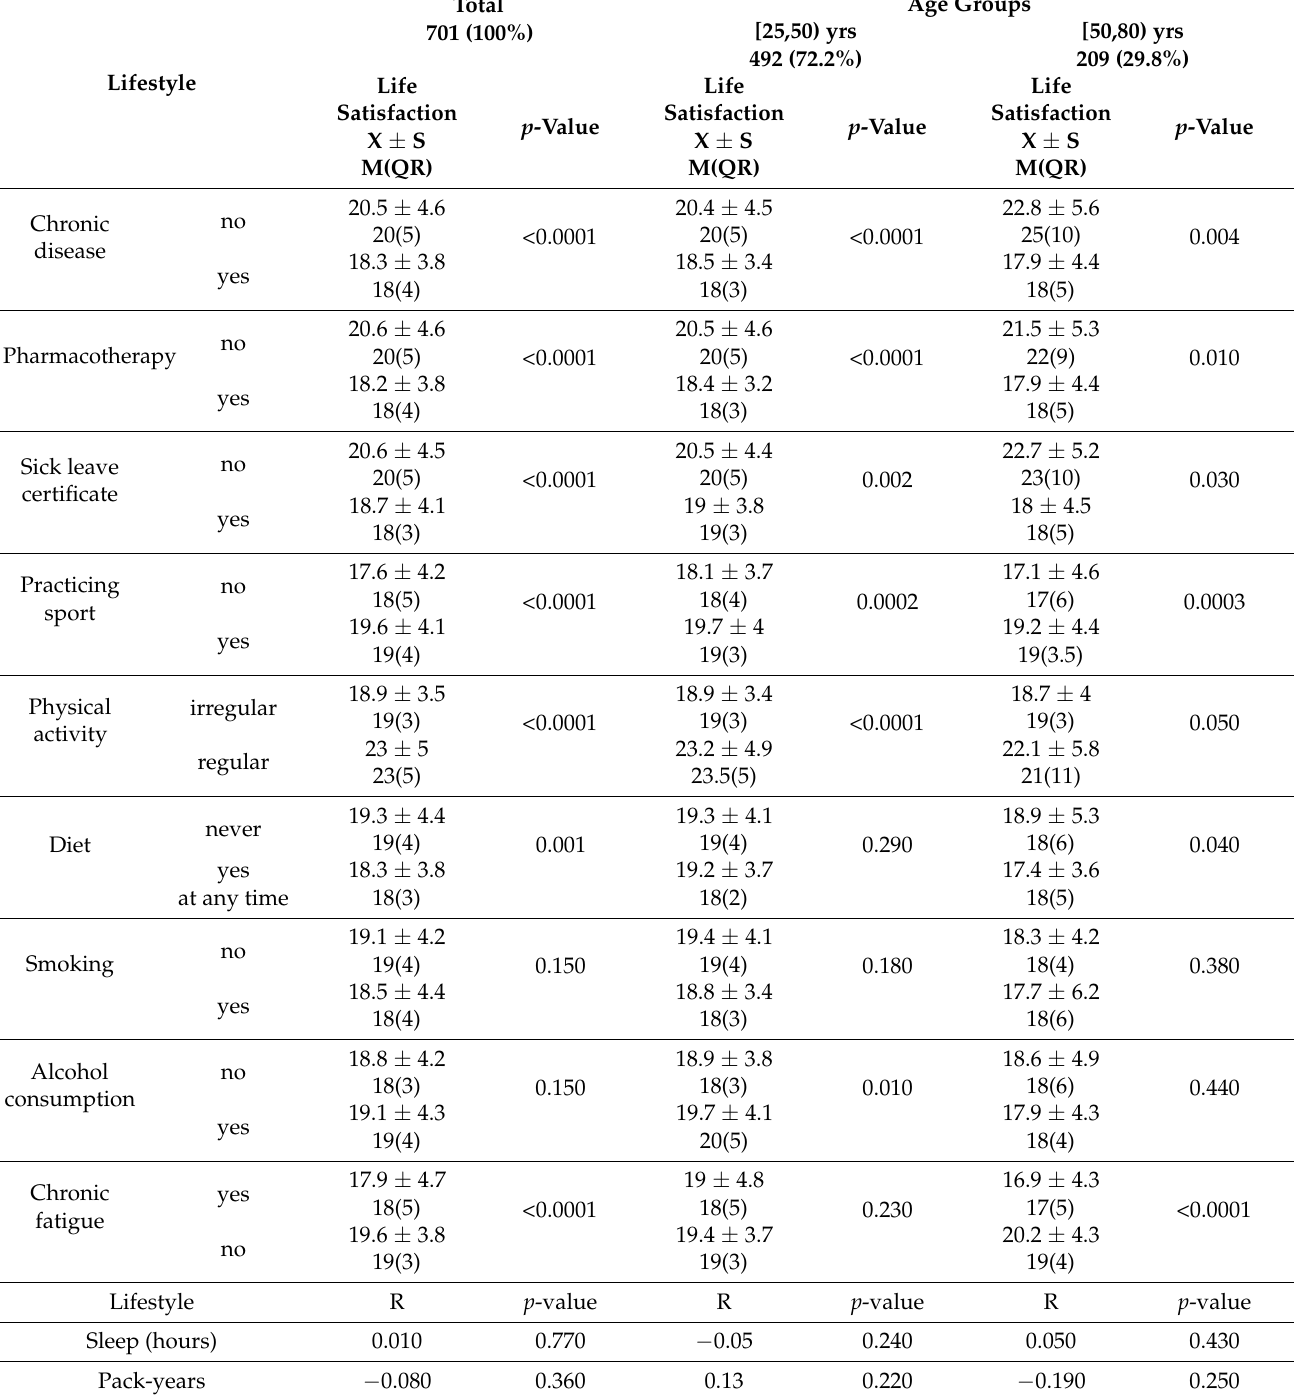
Table 3. Effect of data related to health and lifestyle on life satisfaction of the